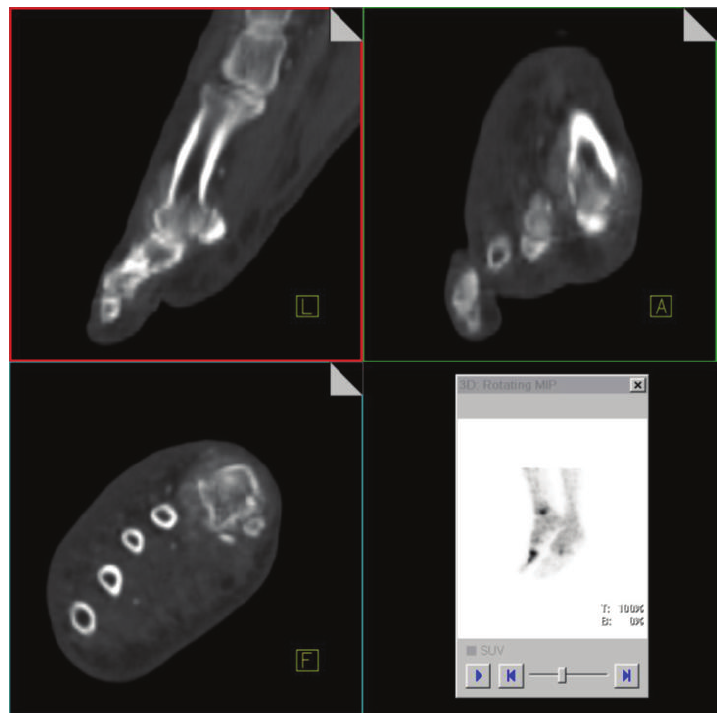
Figure 5: CT-data of the combined SPECT/CT demonstrates soft tissue and periosteal reaction and mild osseous disruptions at the MTP